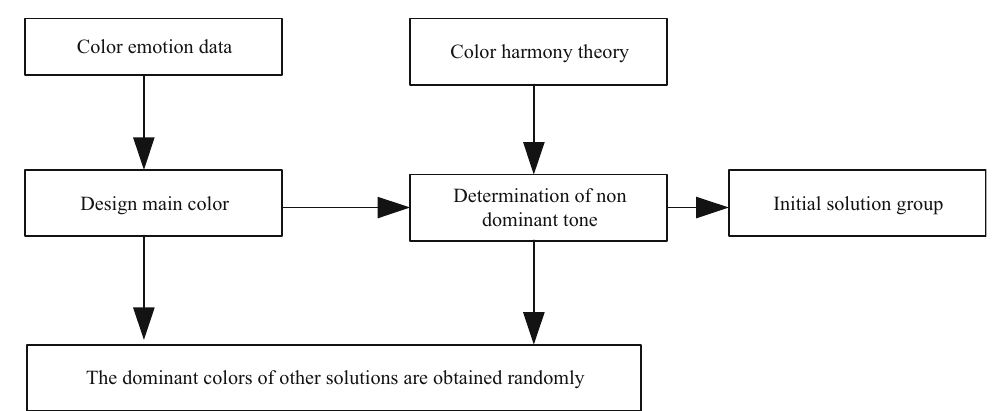
Figure 2: Description process of oil painting color emotional information characteristics.